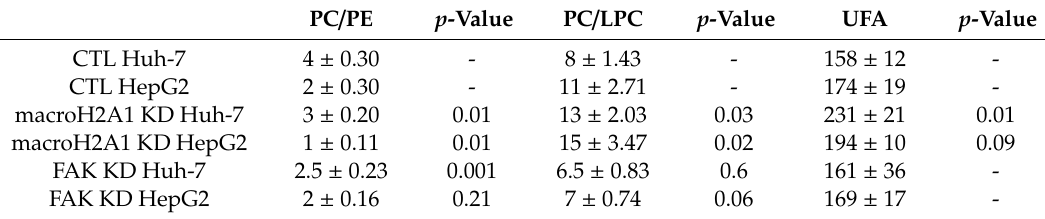
Table 3. Evaluation of PC / PE and PC / LPC ratios, UFA levels (mg / dL) in macroH2A1 KD and FAK KD cell